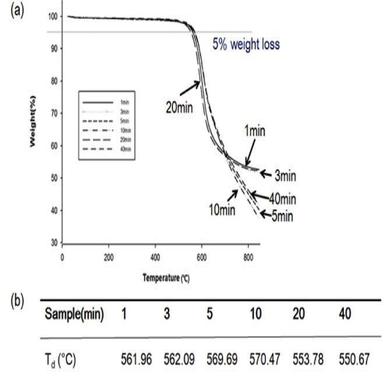
(a) TGA thermogram of PI films at different times (min), and (b) Thermal degradation temperature (Td) of PI films at different times (min). Here, the final curing temperature was 350 °C.